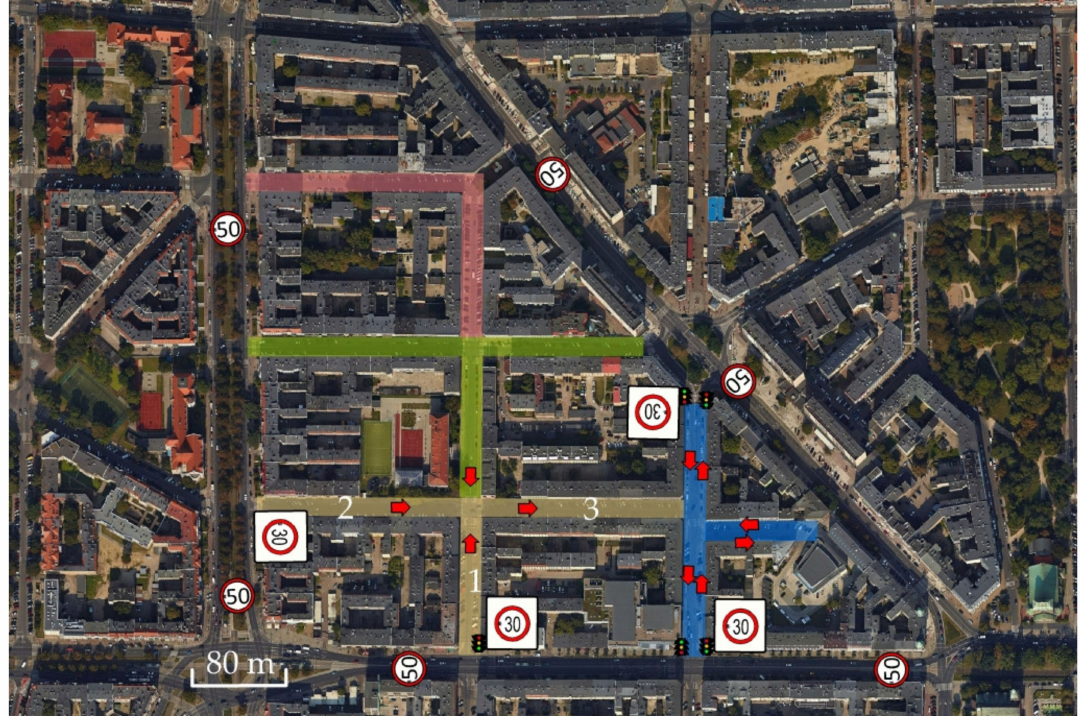
Figure 1. Analysed urban block and testing grounds. Legend: (1) testing ground No. 1; (2) testing ground No. 2; (3) testing ground No. 3. Source: own work of the author using Google Earth satellite imagery